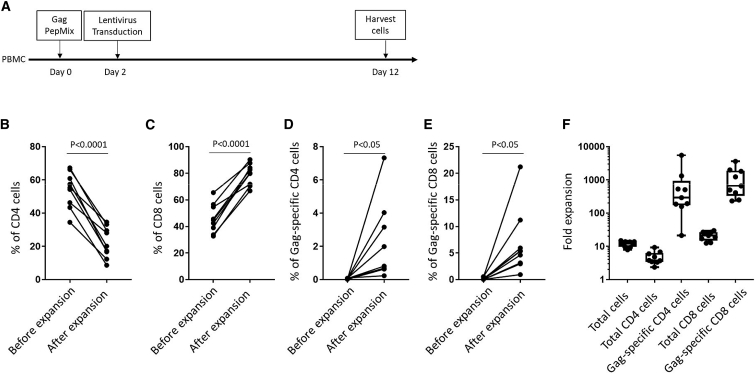
Expansion of HIV Gag-Specific CD4 T Cells by Peptide Stimulation(A) Experimental design to expand HIV Gag-specific T cells. (B, C, D, and E) The percentage of CD4 (B), CD8 (C), Gag-specific CD4 (D), and CD8 T cells (E) before and after expansion. Paired T Tests were performed. All tests were two-tailed and P values of P<0.05 were considered significant. (F) Fold expansion of total cells, total CD4 T cells, HIV Gag-specific CD4 T cells, total CD8 T cells, and HIV Gag-specific CD8 T cells. Boxplots show all points (min to max) and mean.